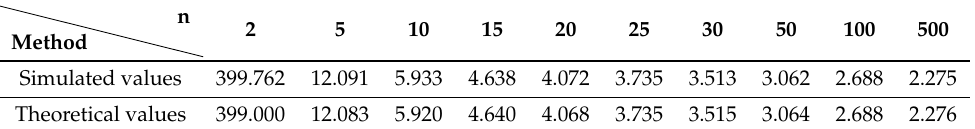
Table 3. Simulated and theoretical 95th percentiles of the maximum order statistics of U 1 , U 2 .